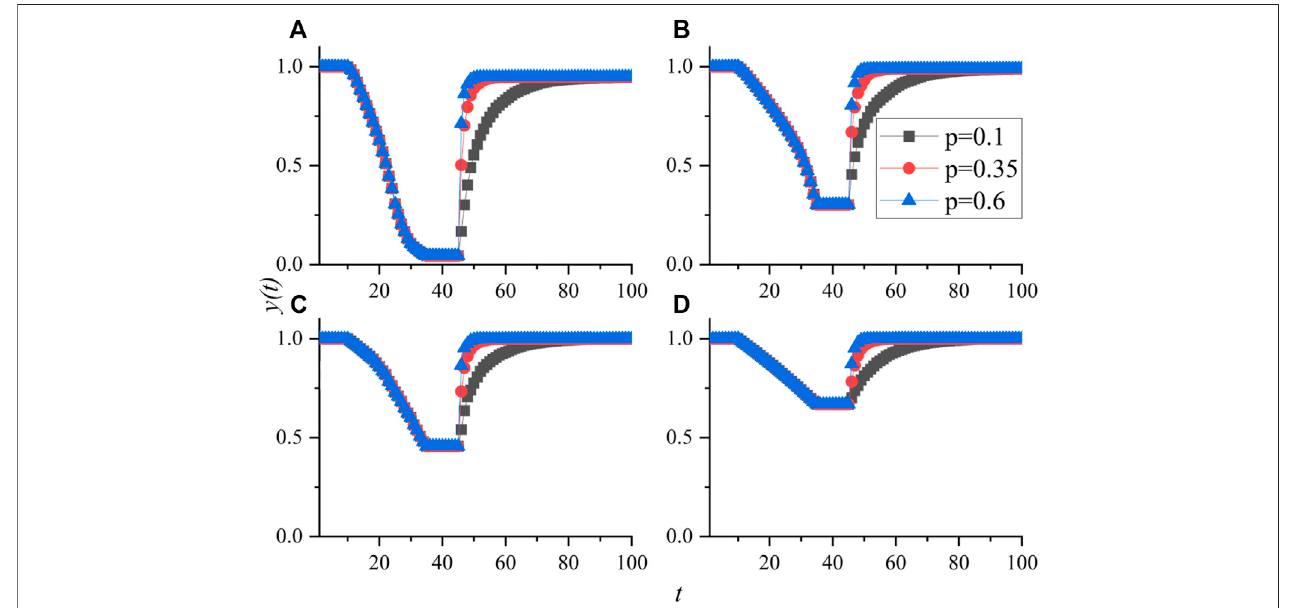
FIGURE 8 | In fl uence of parameter q on the resilience of the four networks. To re fl ect the difference, q is set to 0.1, 0.6, and 1.1, respectively. In addition, the remaining parameters β , and q are set to 0.1.